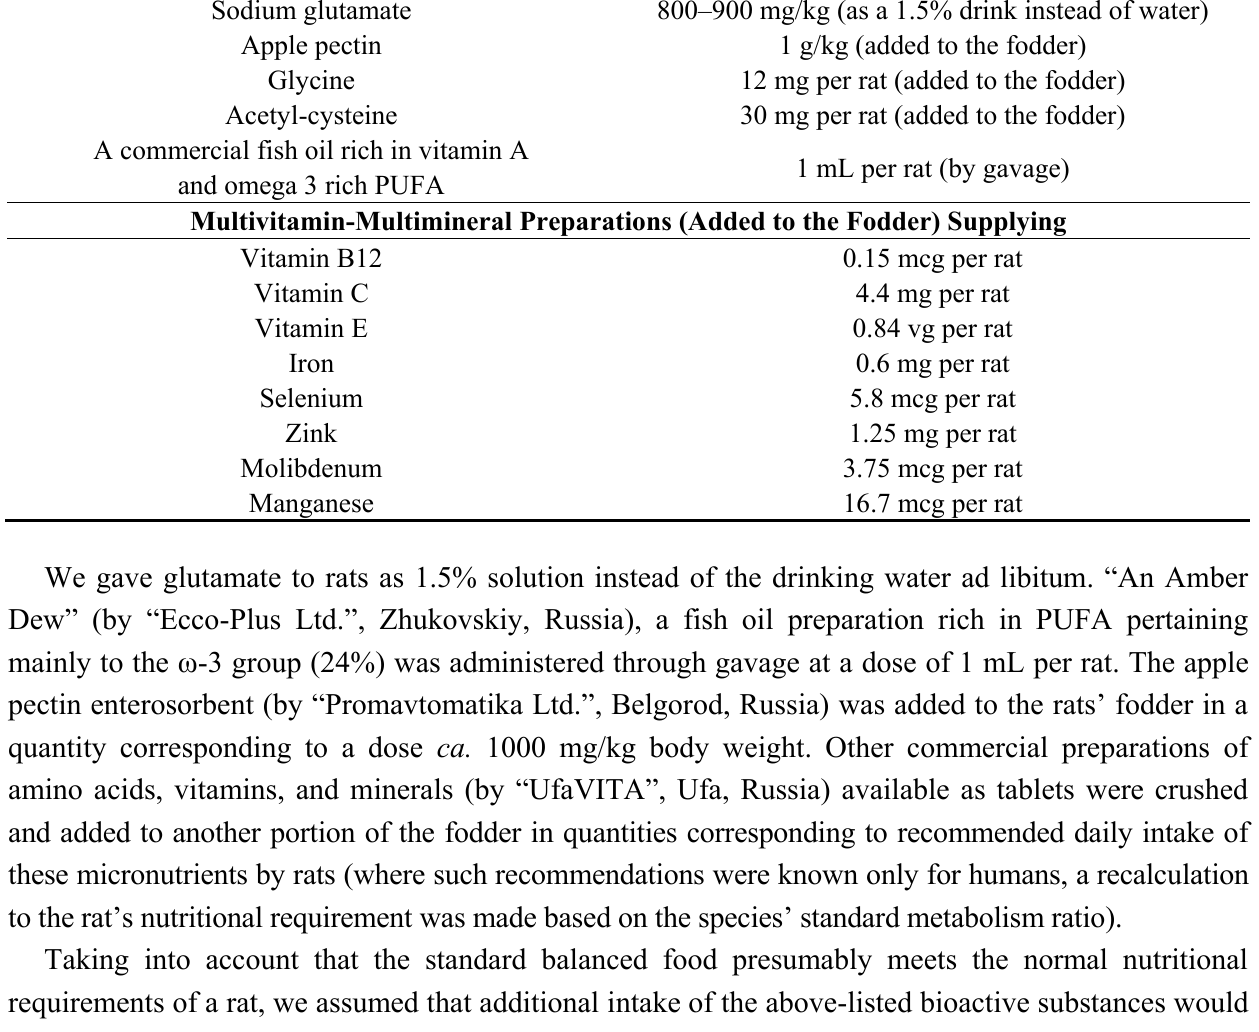
Table 5. Doses and the mode of administration of the bioprotectors tested in our experiment. Bioprotectors (See the Text for